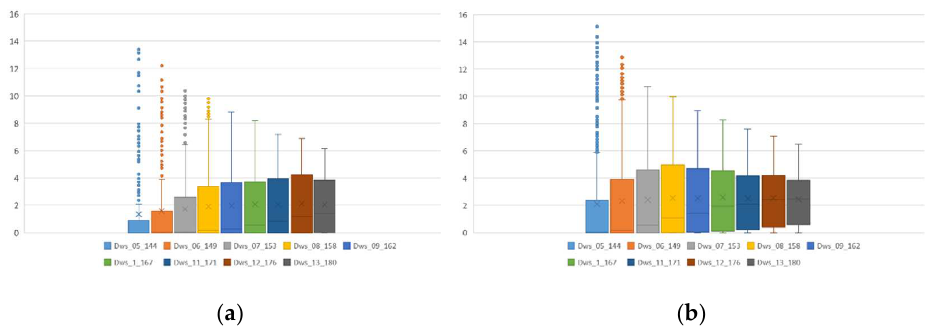
Figure 18. Ranges of WS change for 9 steps in speed- β modifications (Hradec Kralove ( a ) and Ostrava ( b